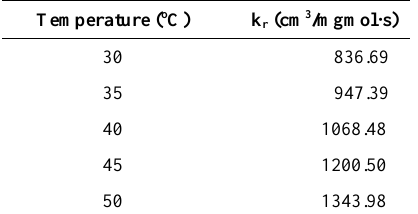
Figure 6. The relationship between the concentration of Ca(OH) 2 mgmol/cm 3 with time at various temperatures The optimization results of the reaction rate constants at various temperatures can be seen in Table 1. Table 1. Optimization of k r at various